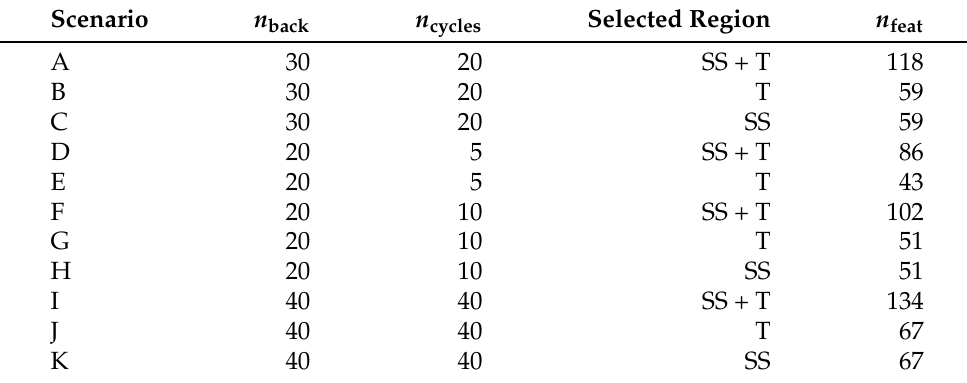
Table 3. Experimental scenarios